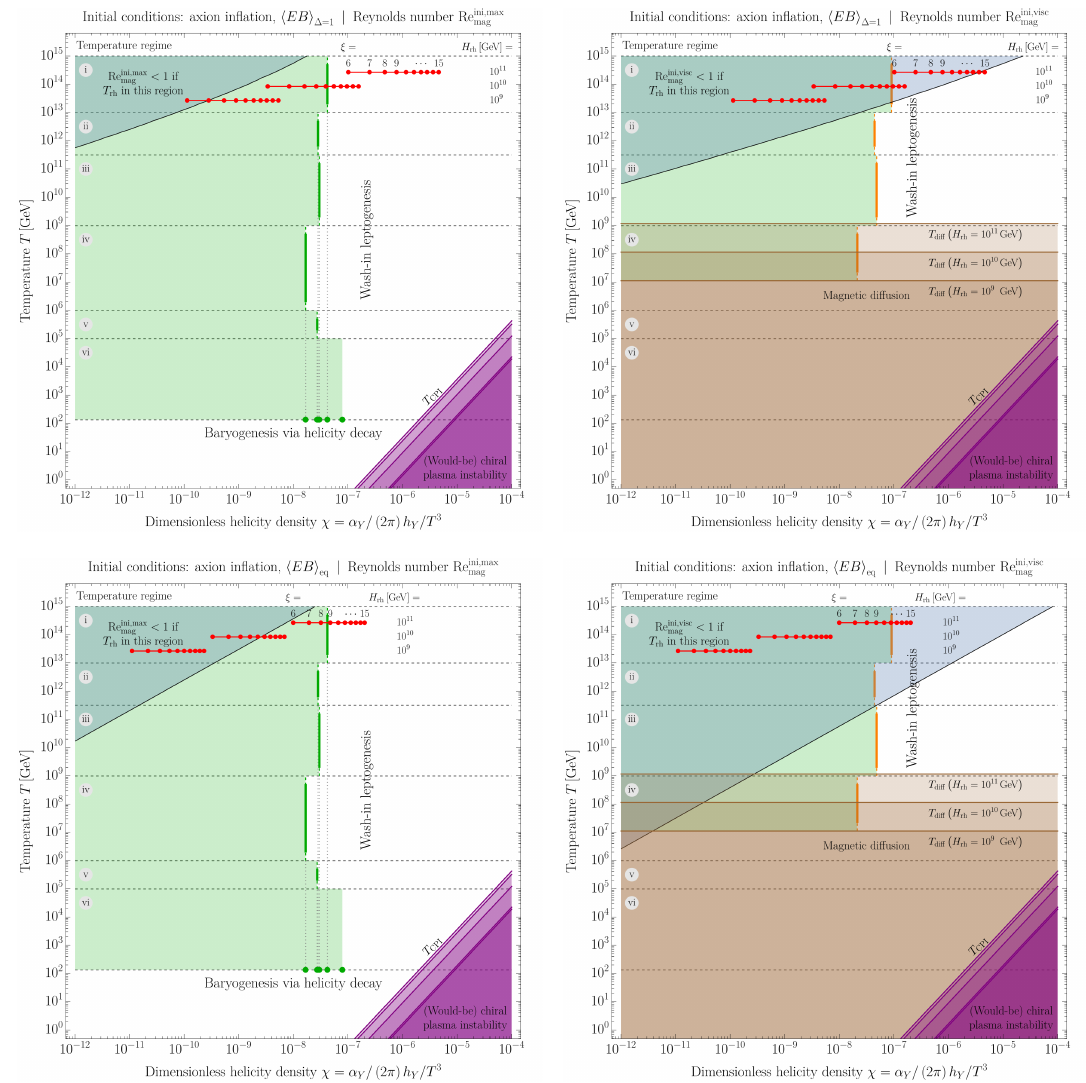
Figure 4 . Viable parameter space for successful baryogenesis after axion inflation. The four panels differ from each other in terms of the estimate of the magnetic Reynolds number, Re ini , max (left mag column) or Re ini , visc (right column), as well as in terms of the method to relate the magnetic energy mag density to the dimensionless helicity density χ , GEF estimate with ∆ = 1 in the electric picture (top row) or equilibrium estimate in the magnetic picture (bottom row) [see eqs. (5.50) and (5.51)]. The red points and red solid lines indicate possible values of χ and T rh that can be achieved at the end of axion inflation in dependence of the parameters ξ and H rh (see figure 1). In contrast to figure 3, we no longer show the brown axis that allows one to convert from T rh to T diff . Instead, we explicitly mark the regions that are ruled out by magnetic diffusion if the initial magnetic Reynolds number is expected to be smaller than unity. All other elements shown in the four plots in this figure are equivalent to the corresponding elements in figure 3. See text for more